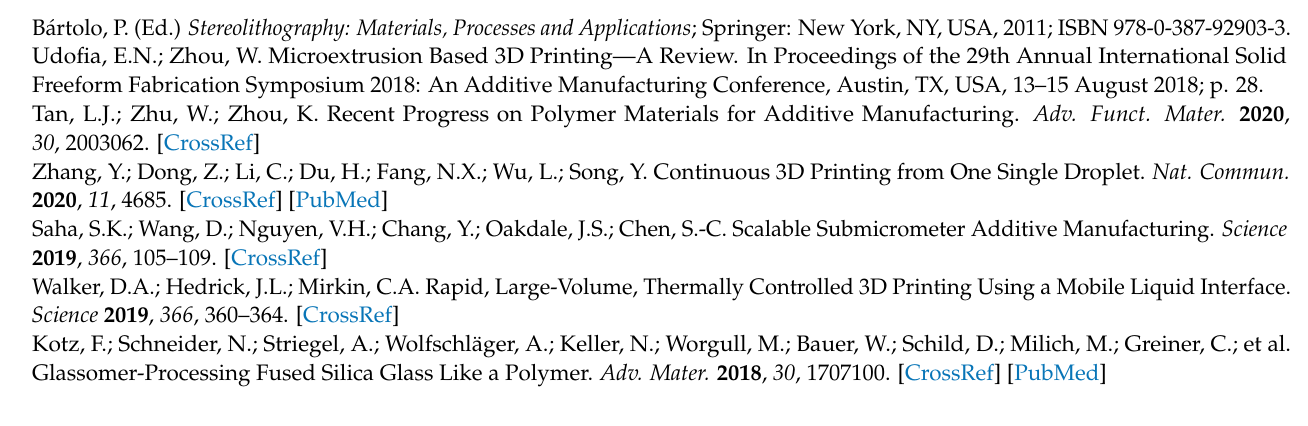
the 7% FS cross-section; Figure S3: Effect of feed rate on printing continuity; Figure S4: Enthalpy of UV-curing resin undre different light